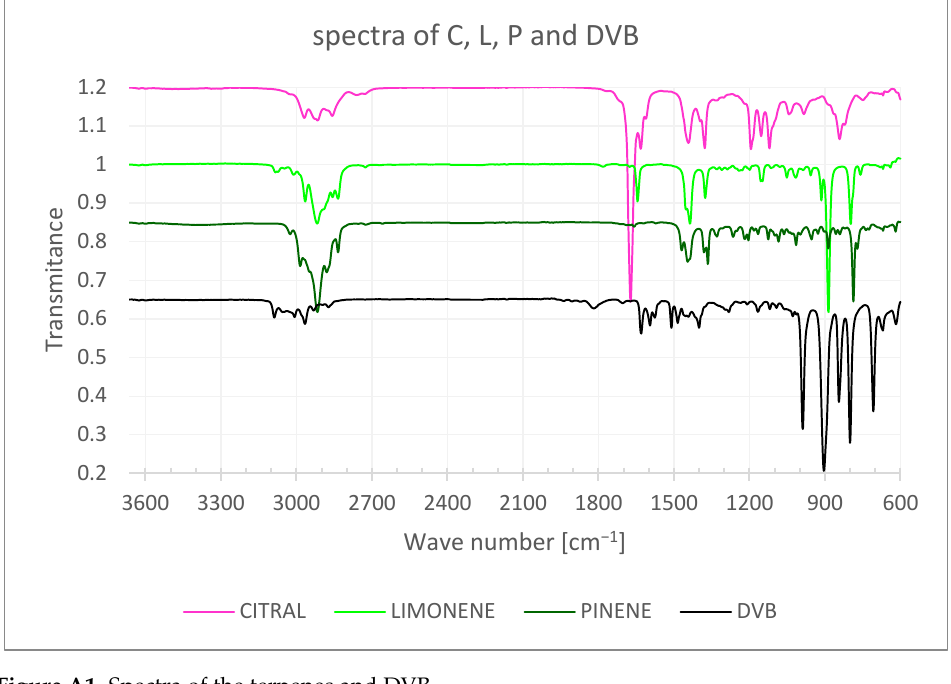
Figure A1. Spectra of the terpenes and DVB.